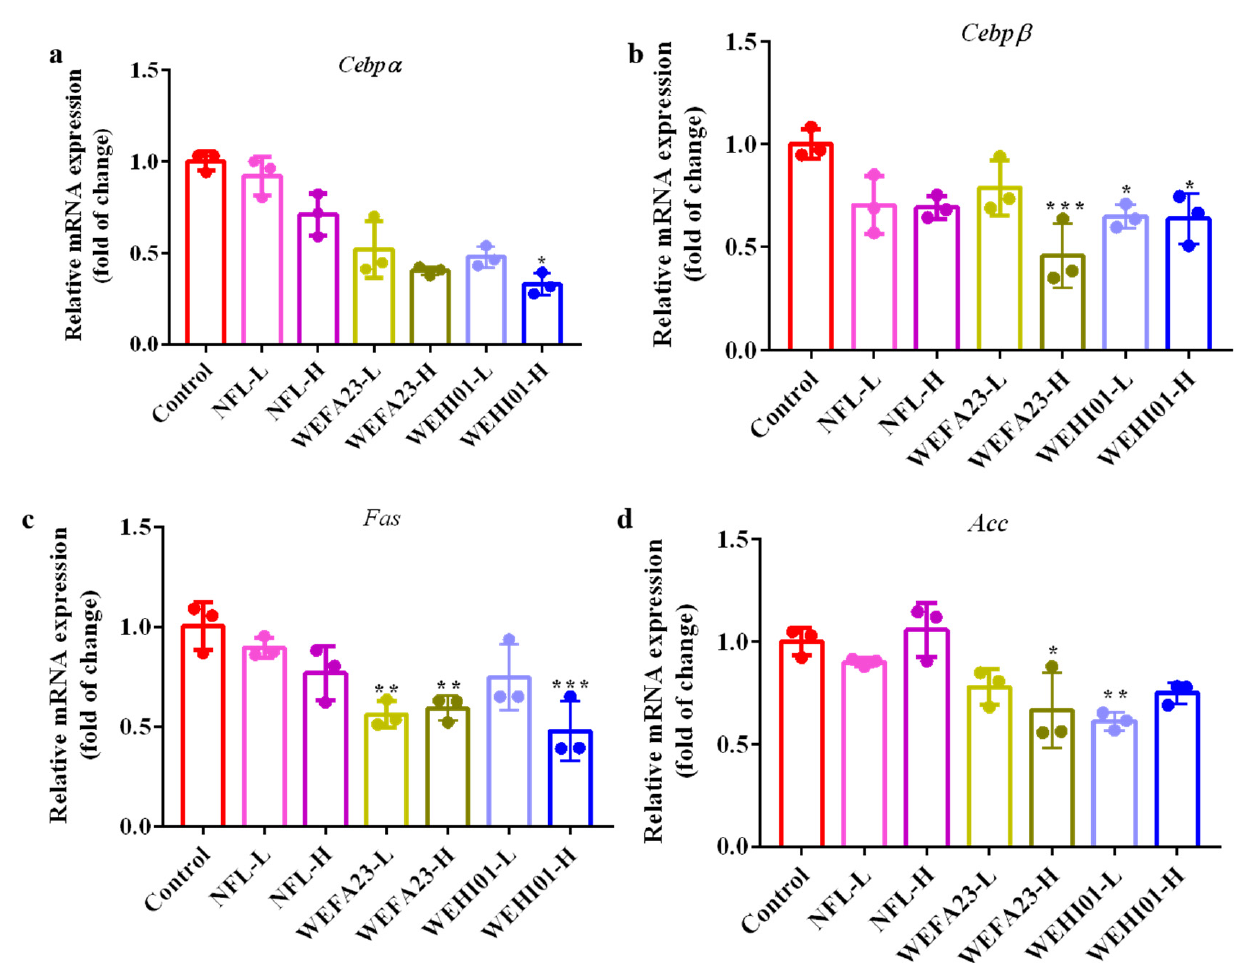
Figure 3. Effect of FLLS-WEFA23 and FLLS-WEHI01 on the mRNA expression of adipogenic genes in 3T3-L1 preadipocytes. The mRNA expression levels of ( a ) Cebp α . ( b ) Cebp β . ( c ) Fas . ( d ) Acc . GAPDH gene was used as reference gene. Values were expressed as mean ± SD ( n = 3). * p < 0.05, ** p < 0.01, and *** p < 0.001 vs. Control.